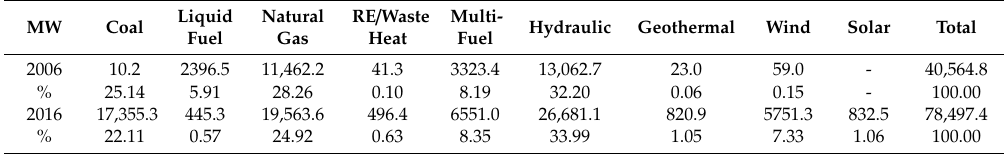
Table 1. Primary Energy Resources Data Obtained from [24] in